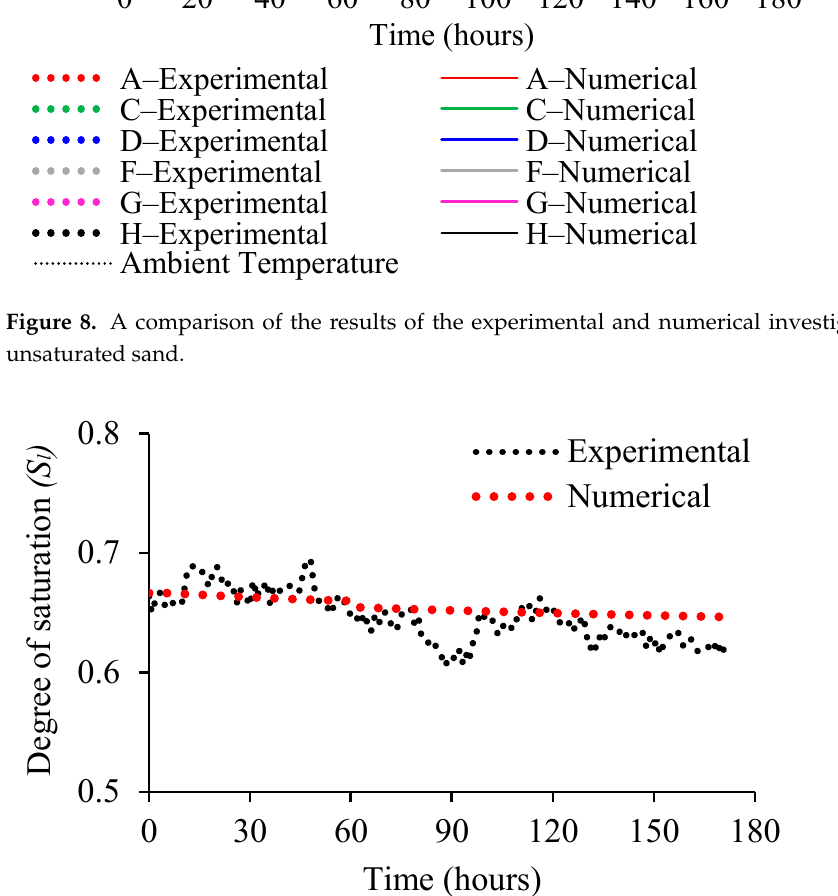
Figure 9. A comparison of the results of the degree of saturation for the experimental and numerical model.